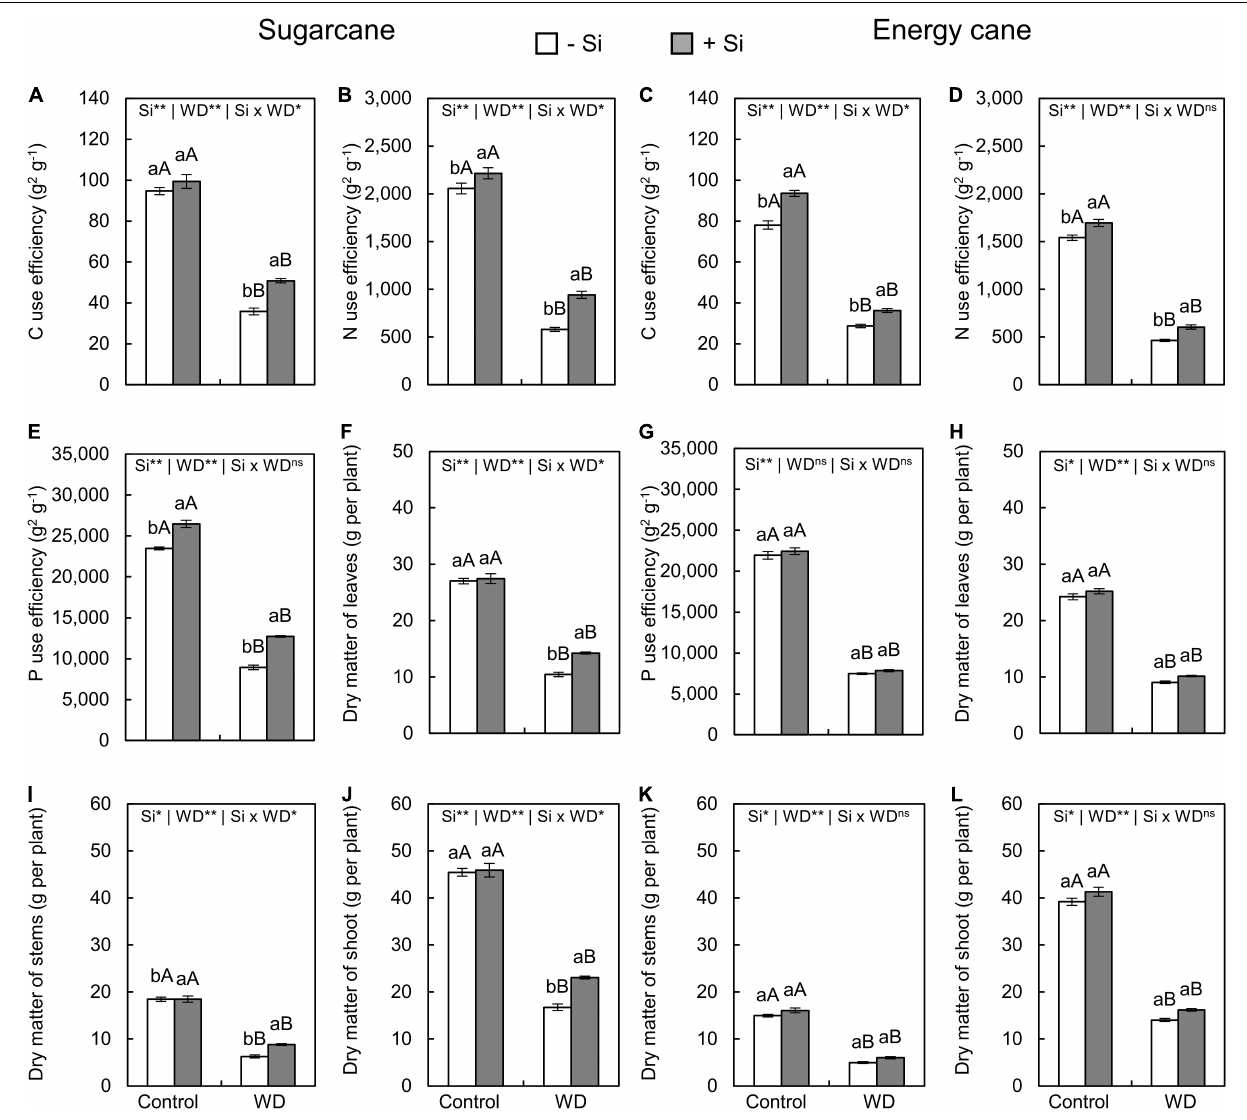
FIGURE 9 | Carbon, N, and P use efficiencies, dry matter of leaves, stems, and shoot of sugarcane (A,B,E,F,I,J) and energy cane (C,D,G,H,K,L) in -Si and + Si under adequate water regime (control) and in WD for a period of 7 to 60 days after transplantation. ** and * significant with 1 and 5% probability, respectively, and ns, not significant by the F -test. Lowercase letters indicate differences in relation to Si and capital letters in relation to water deficit. n = 6. Si × WD: